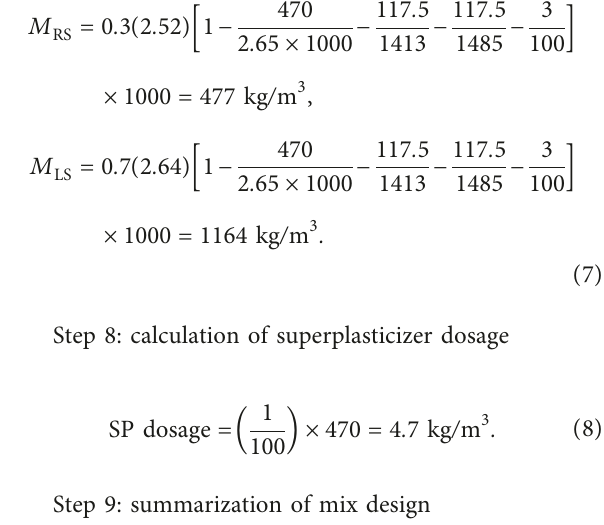
Figure 11: Twenty-eight-day compressive strength versus the AAS/FA ratio